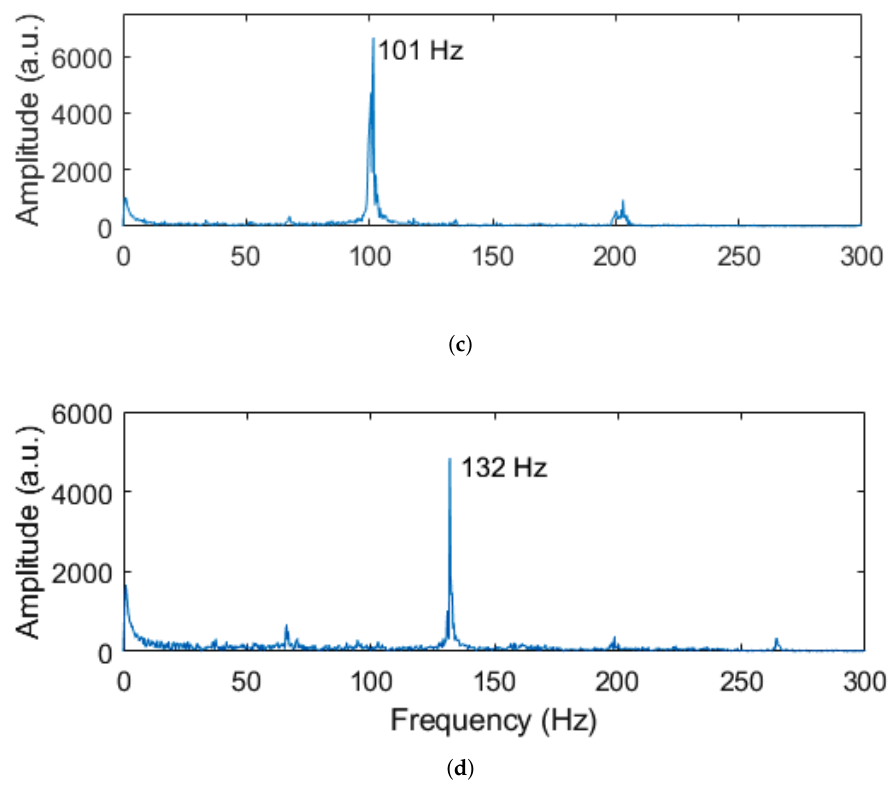
Figure 13. Frequency spectra of the sensors’ responses for different excitation frequencies of the motor: ( a ) 16 Hz, ( b ) 65 Hz, ( c ) 101 Hz, and ( d ) 132